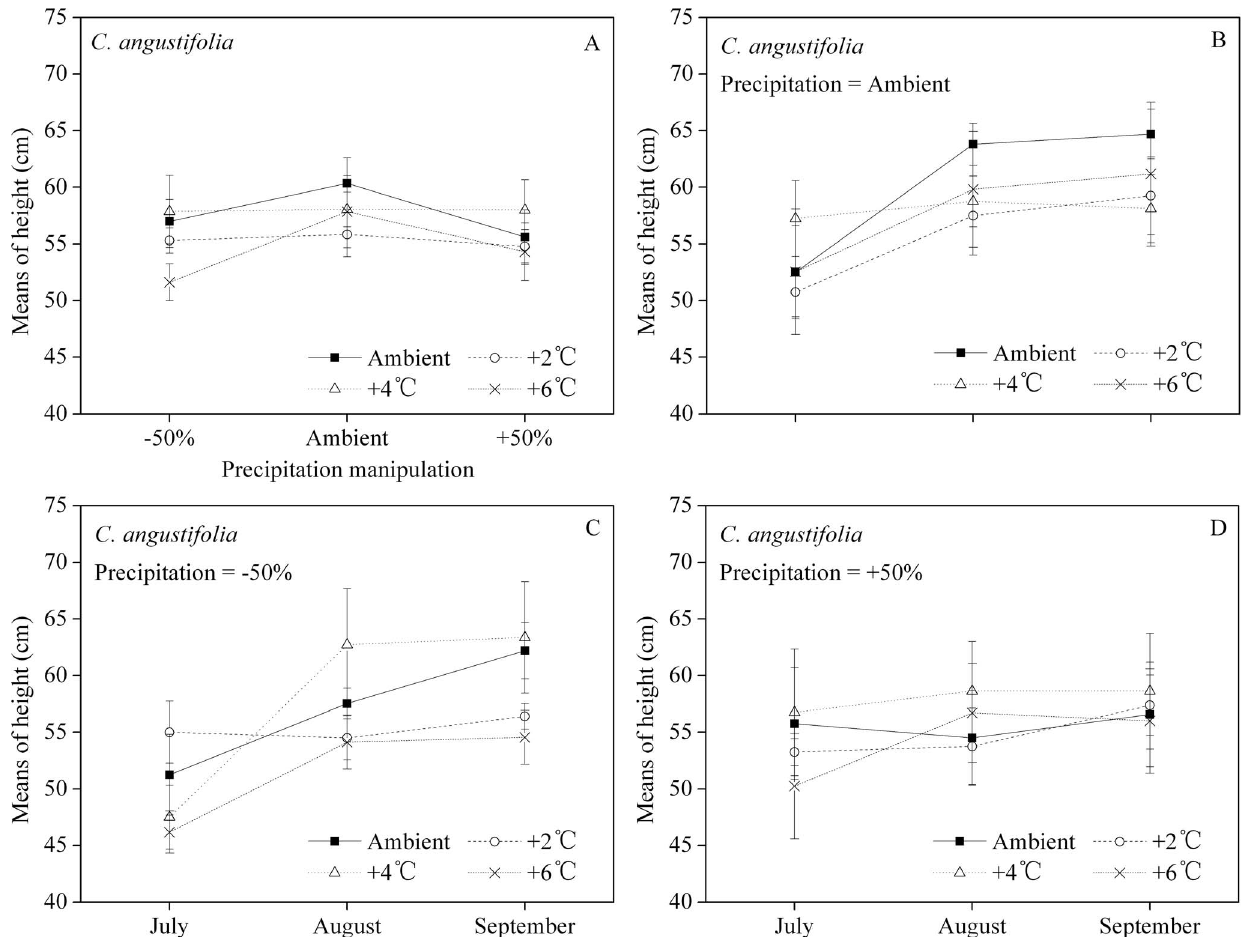
Figure 1. Interaction of temperature and precipitation manipulations on plant height (A) of Calamagrostisangustifolia , and the monthly estimated marginal means of height of C. angustifolia for different temperature treatments when precipitation was manipulated at ambient (B), 2 50% (C) and + 50% (D) levels, respectively. The error bars represent means 6 1 standard error.